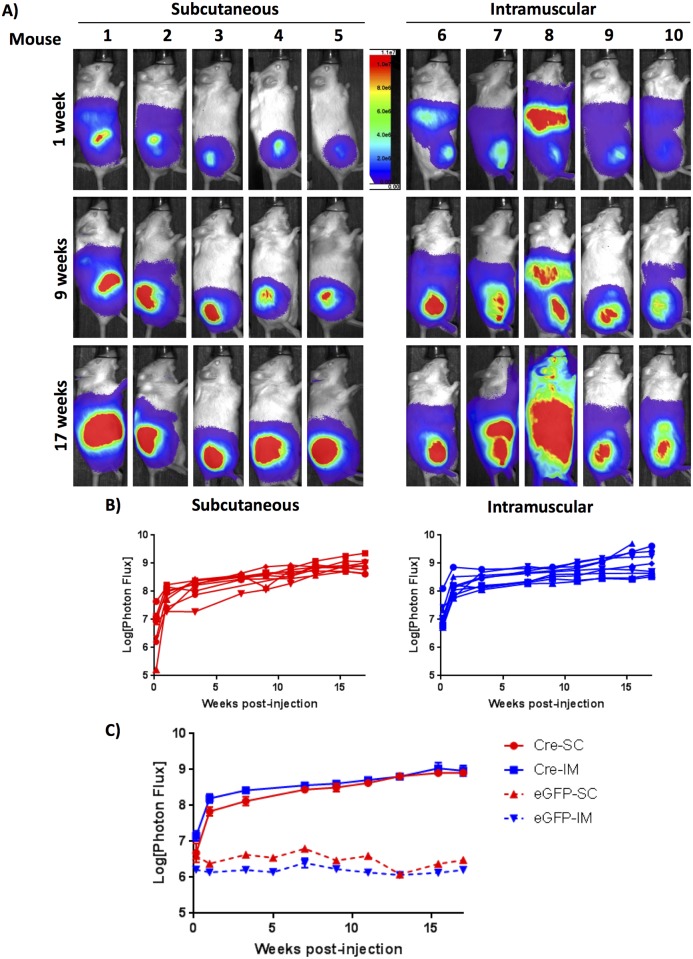
Trp53/Pten mice injected with Ad CMV-Cre demonstrate a longitudinal increase in BLI signal.A) BLI of Trp53/Pten mice injected either SQ or IM with Ad CMV-Cre. Mice were injected with intraperitoneal D-luciferin and imaged using an Ami X imager. Shown are representative images of five mice from each cohort at 1 week, 9 weeks, and 17 weeks post-viral injection, demonstrating a steady increase in luciferase signal over time. B) Quantified whole-body in vivo BLI values as measured in photons/sec/cm2/sr are shown for individual mice for each injection group (n = 9), and compared between the two injection groups C), highlighting similar luciferase expression kinetics and values between SQ- and IM-injected animals. The difference between SQ and IM injection was statistically significant for day 1 post-injection (p = 0.045), but not thereafter. From the 2way ANOVA, overall variance due to injection method was statistically significant (p = 0.0019). In comparison to the first day post-injection, all values for both injection methods were significant (p<0.0001).